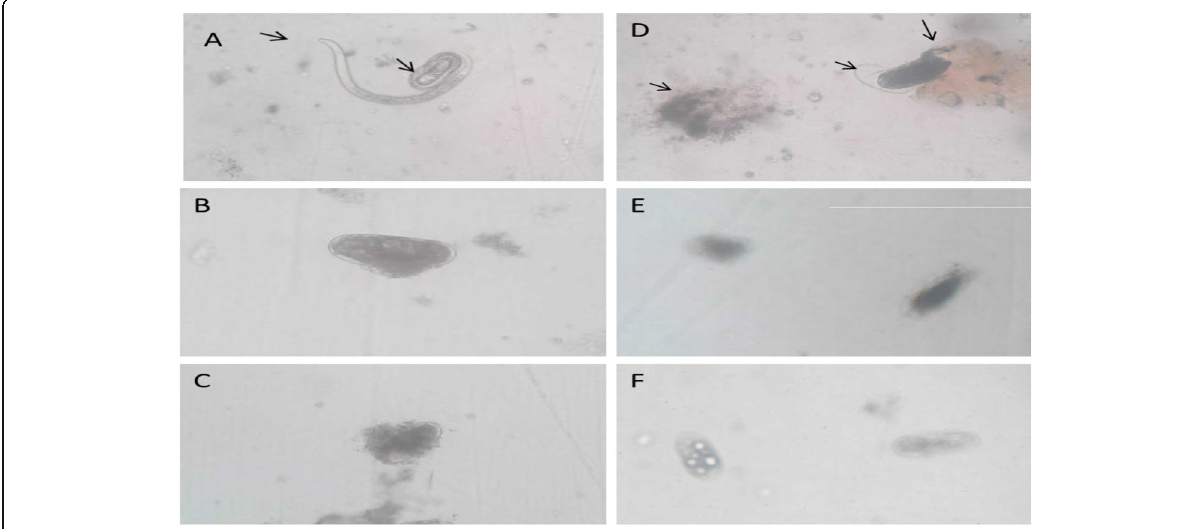
Fig. 2 Hatching is observed in the water control; normal juvenile and normal egg ( a , arrows). Abnormal development stages are occurred: deforming of eggshell occurred ( b , c , e ); some eggshells appeared to be destroyed and abnormal hatching ( d , arrows). Arrow reveals some